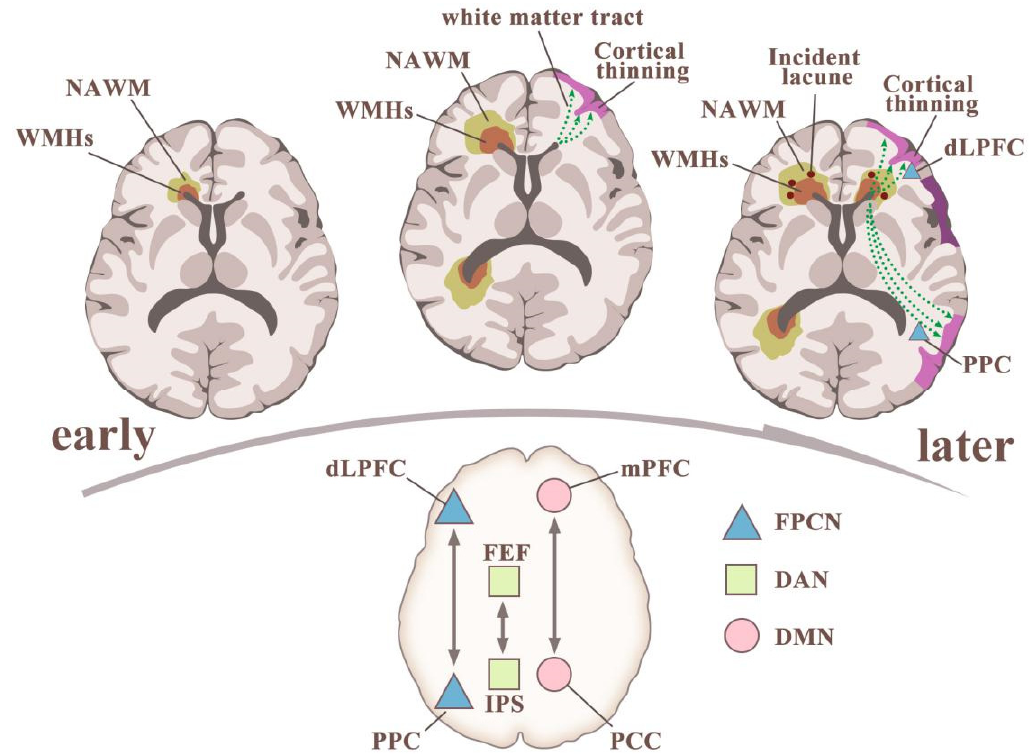
Figure 1. The association between white-matter hyperintensities (WMHs) and cognitive impairment: insights from imaging. Upper left: Interstitial fluid increase leads to WMHs and affects the normal-appearing white matter (NAWM) around it. Patients with WMHs have greater blood-brain-barrier leakage than do controls in the WMHs, NAWM, and cortical gray matter. Upper middle: WMHs progress, leading to secondary cortical thinning and possibly white-matter tract lesions in the NAWM and WMHs. Upper right: WMHs are present, incident lacunae might appear, secondary cortex is thinned, long-tract degeneration worsens, and major attentional networks and their hubs have been injured. (4) The three commonly studied attention networks and their hubs are interrelated. The default-mode network (DMN) includes the medial prefrontal cortex (mPFC) and posterior cingulate cortex (PCC) as major hubs. The frontoparietal control network (FPCN) includes the dorsolateral prefrontal cortex (dLPFC) and the posterior parietal cortex (PPC) as major hubs. The dorsal attentional network (DAN) includes the frontal eye fields (FEF) and the area around the intraparietal sulcus (IPS) as major hubs